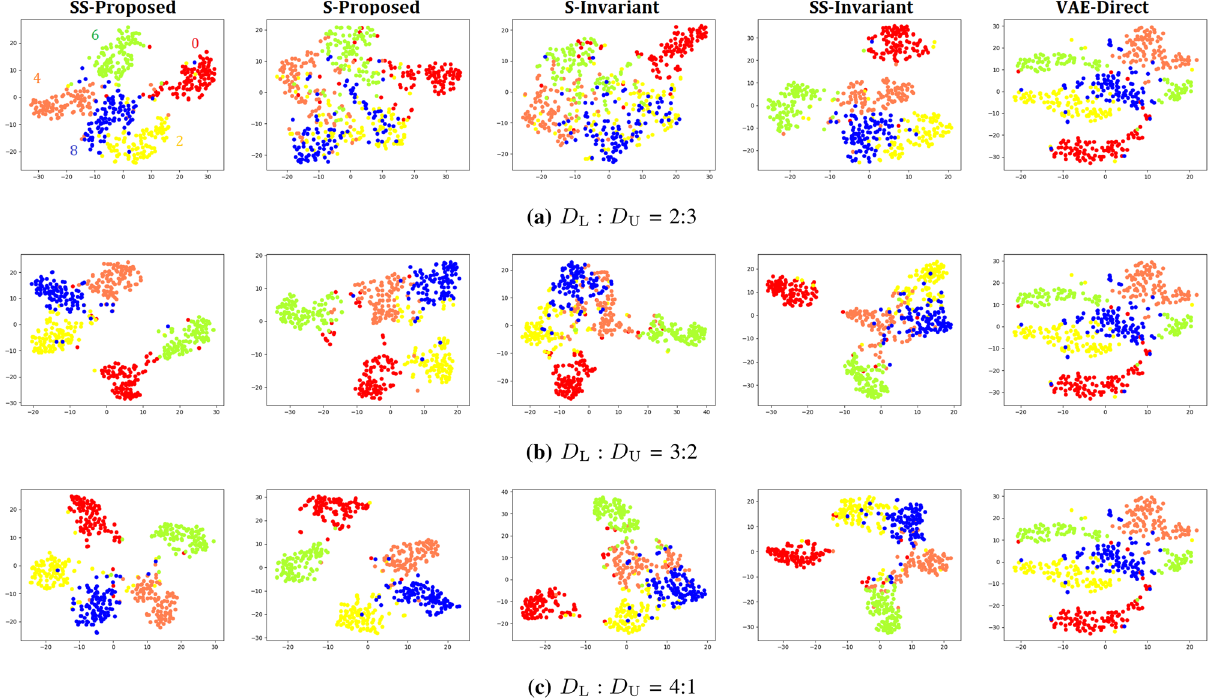
Fig. 3 Visualization of the embedded data for the unseen domain (0-degree domain) on MNIST-r. Each column represents SS-Proposed, S-Pro- posed, S-Invariant, SS-Invariant, and VAE-Direct, respectively, from left to